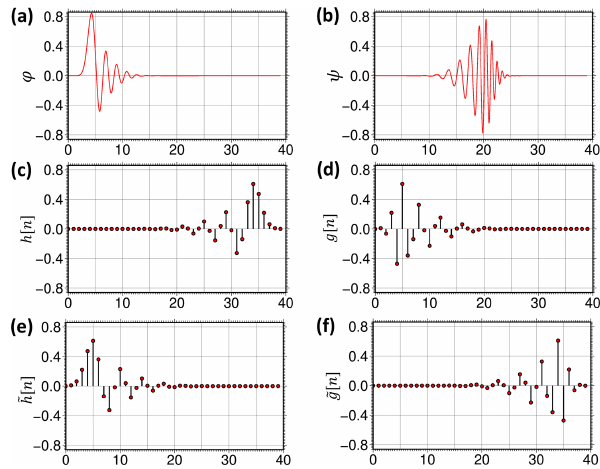
Figure 3. Daubechies-20 (a) scaling function, (b) wavelet function, (c) decomposition low-pass filter, (d) decomposition high-pass fil- ter, (e) reconstruction low-pass filter, and (f) reconstruction high- pass filter.